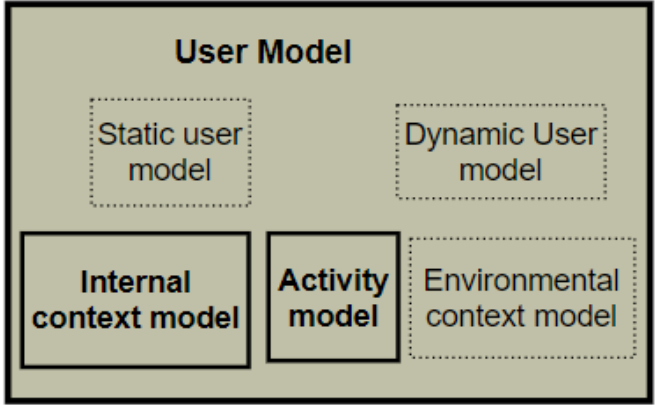
Figure 4. The Expanded User Model.